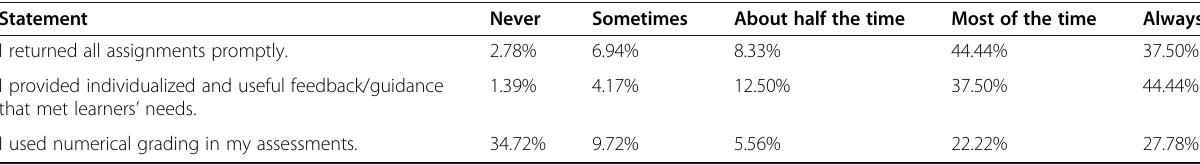
Table 3 Teachers ’ responses on their assessment strategies during ERT